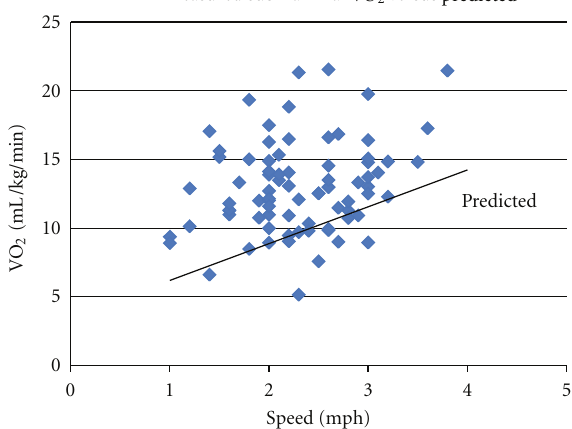
Figure 1: Submaximal VO 2 measured at self-selected walking speed during the last 40 seconds of the first 2-minute stage of treadmill test versus walking speed in mph. Diamonds show measured values, where solid line shows expected value (VO 2 mL/kg/min predicted = 0.1 × 26.8 speed in mph + 3.5). The vast majority of subjects had measured values higher than the predicted values indicative of poor economy of